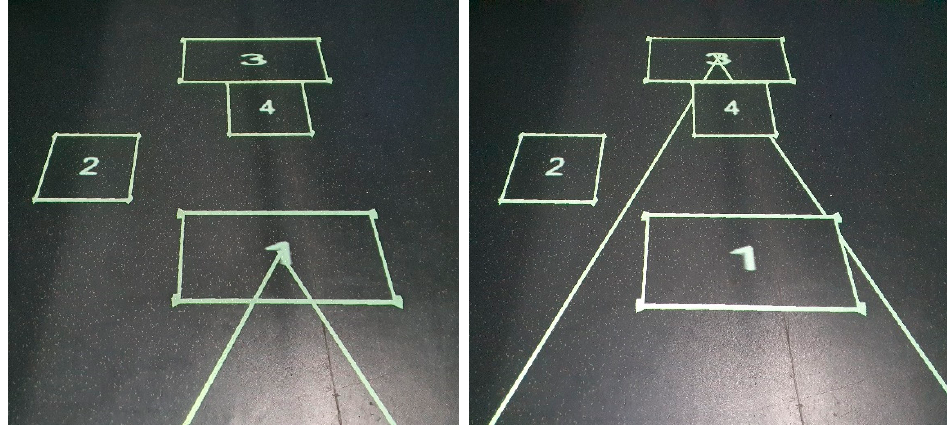
Figure 5. Two tramlines converging on the middle of an outline on which the user is focused in the HMD. Showing object 1 selected ( left ) and then object 2 selected ( right ). Lines begin either side of the current user. The reflection is from a skylight and is not part of the indicator.